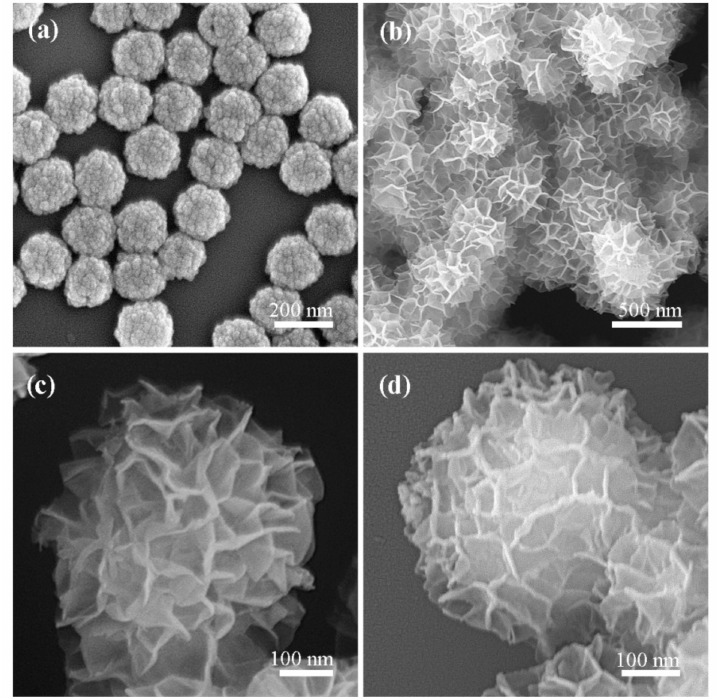
Figure 1. SEM images of hollow Fe 3 O 4 microspheres ( a ), hollow flower-like Fe 3 O 4 / MnO 2 microspheres ( b , c ), and hollow flower-like Fe 3 O 4 / MnO 2 / Mn 3 O 4 photocatalyst ( d